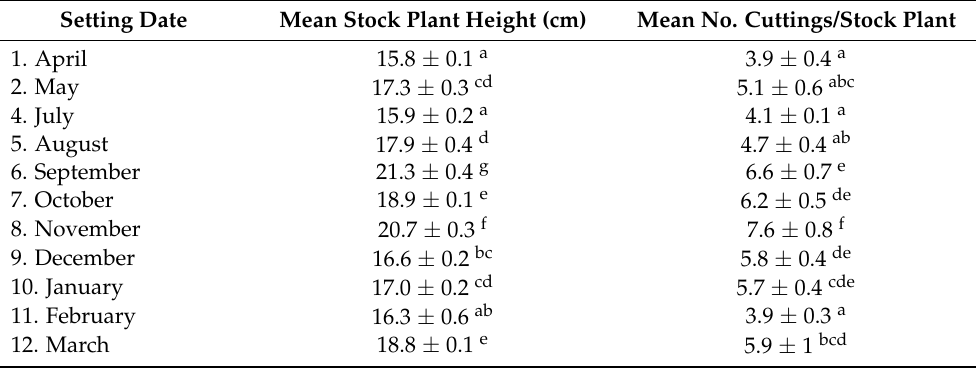
Table A3. Setting date means (i.e., data pooled across densities) for stock plant height before the collection of mini cuttings and stock plant productivity (mean number of mini cuttings per stock plant) for coir. Means followed by the same letter show no significance at the 95% confidence